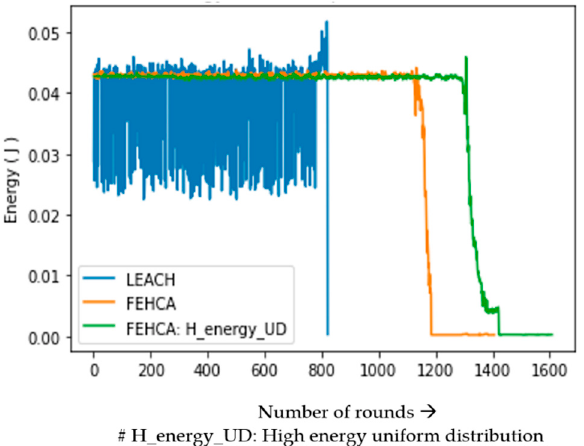
Figure 11. Energy dissipation comparison per round in LEACH and FEHCA.